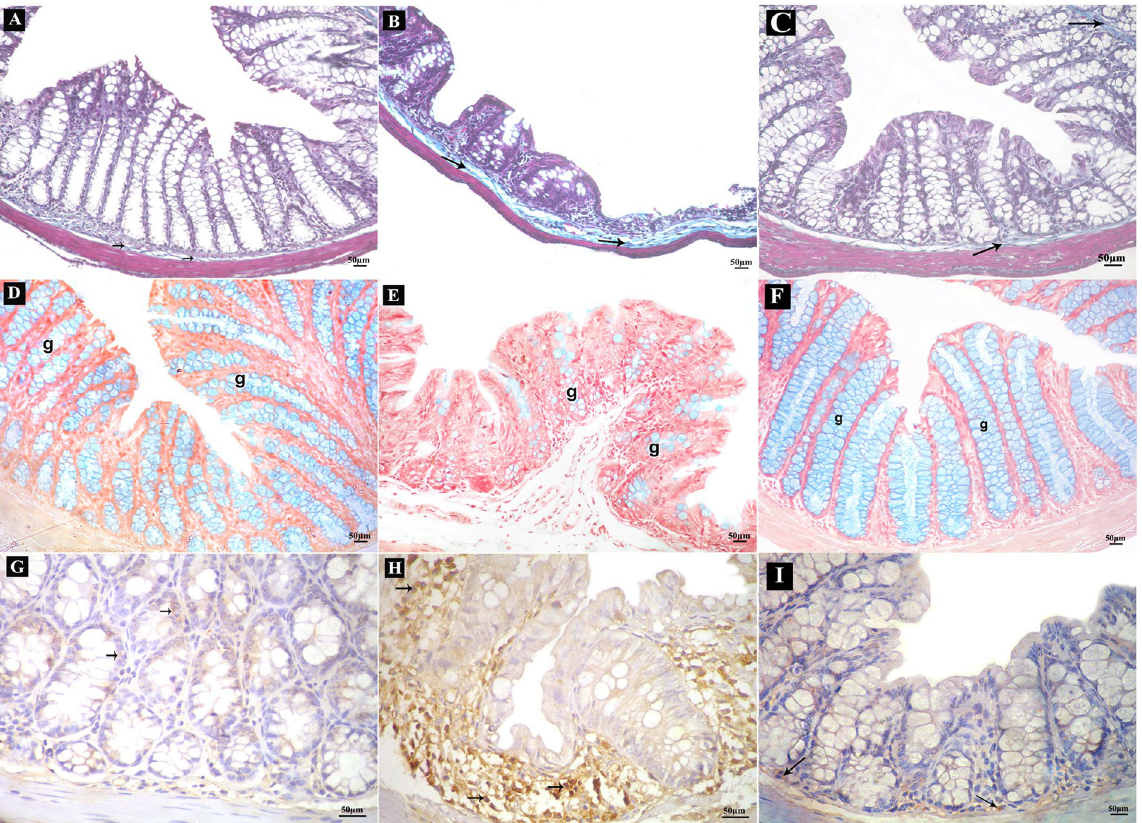
Figure 6. Sections of the colon of adult male mice. ( A – C) Mallory’s trichrome-stained sections (200x); collagen fibers (arrows). ( A ) Control group showing few collagen fibers, ( B ) DSS group showing numerous collagen fibers, ( C ) DSS + AuNPs group showing some collagen fibers. ( D – F ) Alcian blue-stained sections (200x); goblet cells (g). ( D ) Control group with abundant goblet cells, ( E ) DSS group with few goblet cells, ( F ) DSS + AuNPs group with many goblet cells. ( G – I ) Immune histochemical-stained sections for IL-17A (400x); brown positive cytoplasmic reactions (arrows). ( G ) Control group showing reactions in few cells, ( H ) DSS group showing reactions in many cells, ( I ): DSS + AuNPs group showing reactions in some